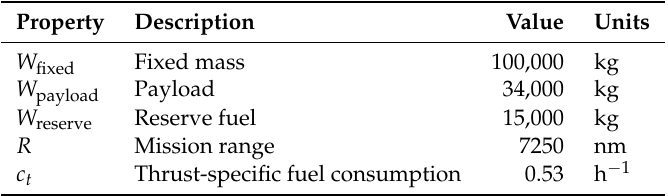
Table 2. Aircraft